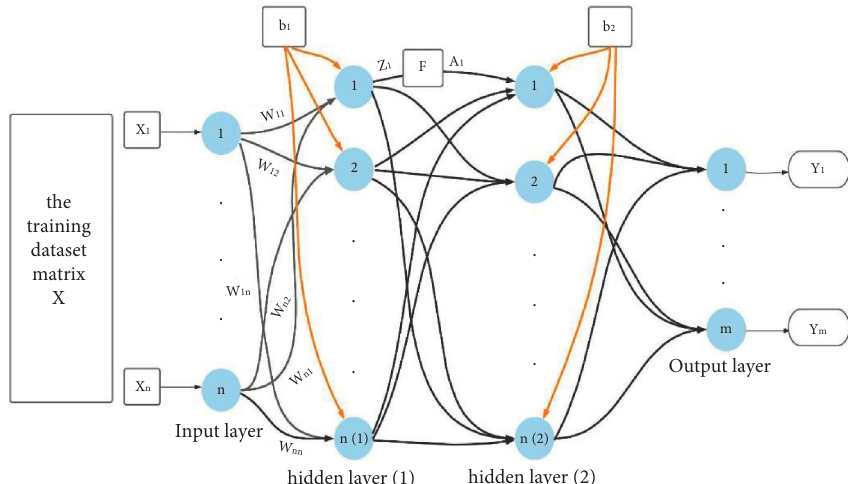
Figure 5: A simple DNN architecture with two hidden layers.